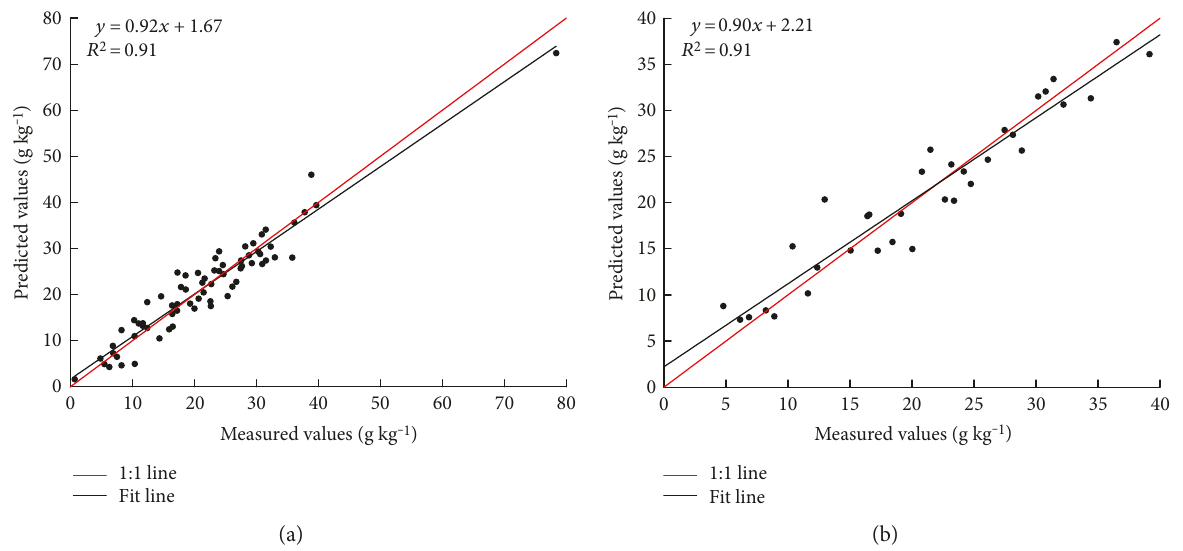
Figure 5: Comparison of measured SOM content and estimated values of modeling sample (a) and testing sample (b) through R 1.8-order derivative. Table 3: Performance statistics of absorbance model for calibration set and validation set based on